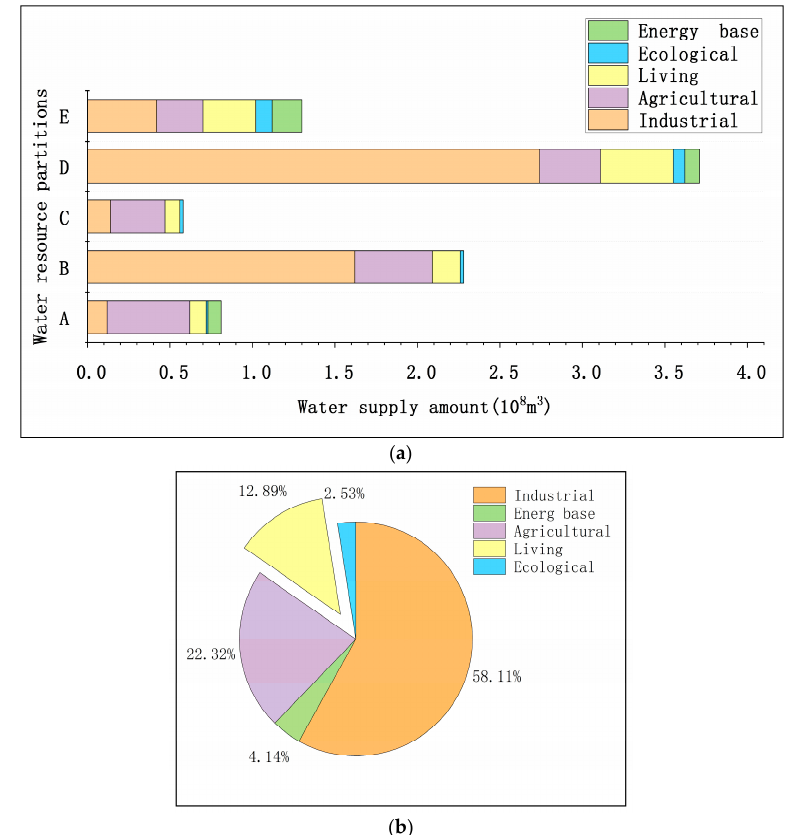
Figure 9 ( a ) Water supply analysis chart of model method (In the figure, Pastoral Energy